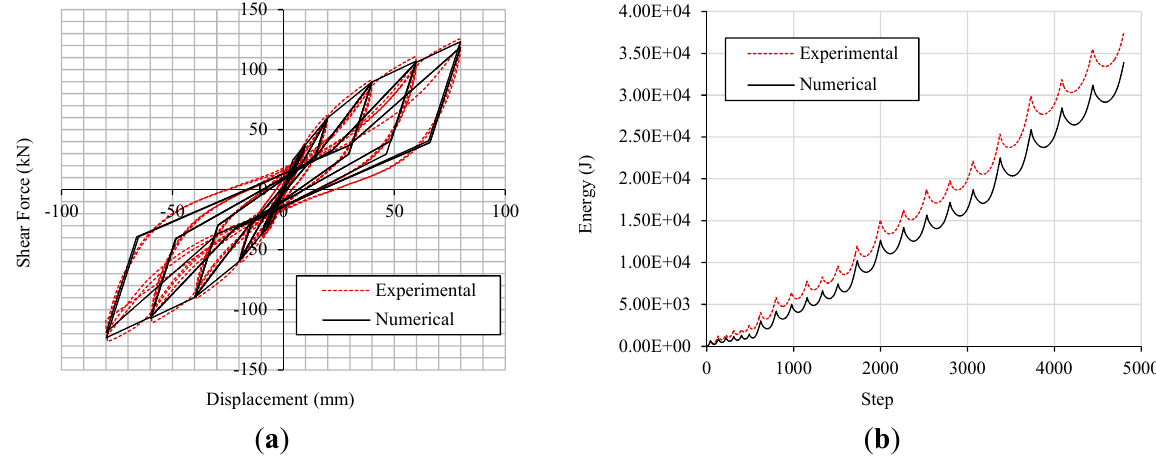
Figure 19. Wall C: ( a ) Hysteresis loops; ( b ) Dissipated